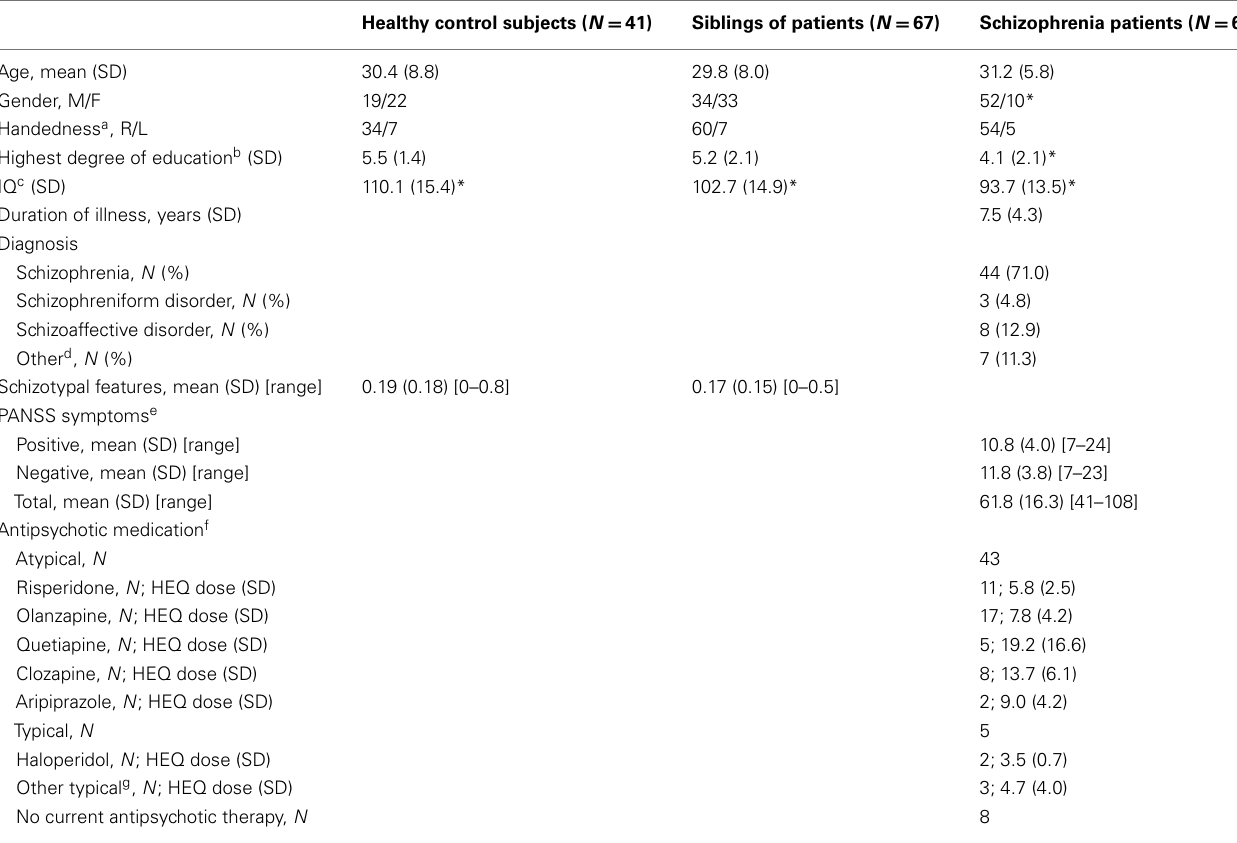
Table 1 | Demographic and clinical characteristics.